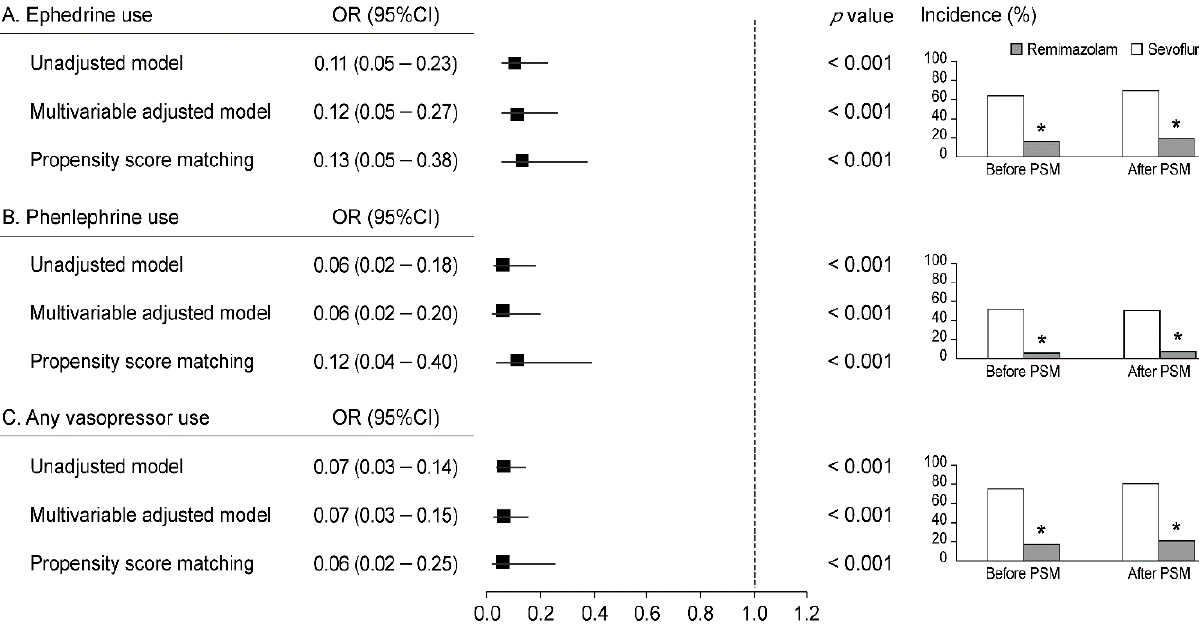
Figure 3. Forest plot and bar graph depicting the association of ( A ) ephedrine use, ( B ) phenylephrine use, and ( C ) any vasopressor use with remimazolam anesthesia vs. sevoflurane anesthesia. OR, odds ratio; 95% CI, 95% confidence interval; PSM, propensity score matching. * p < 0.05 vs. sevoflurane group.